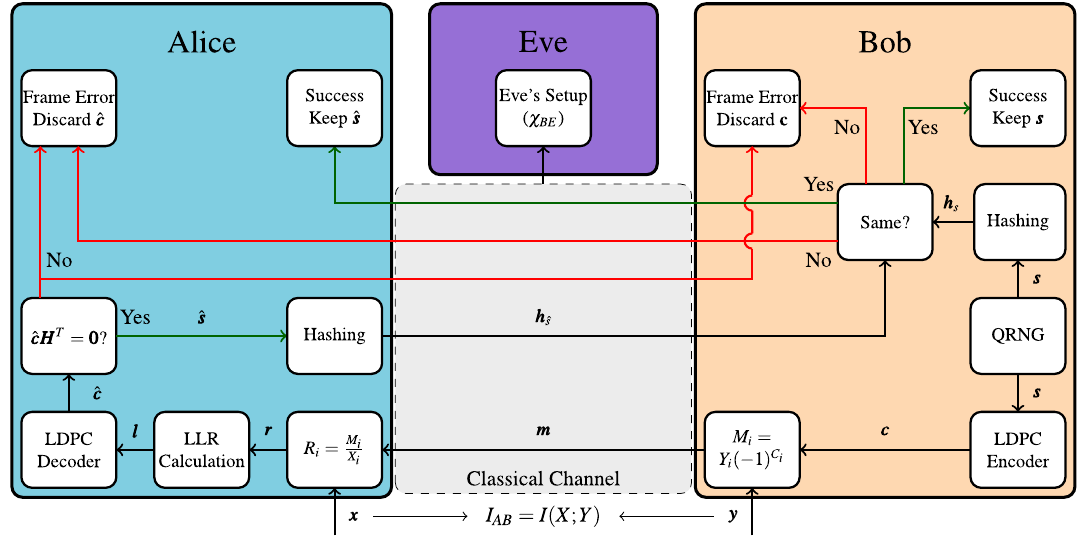
Figure 7. An overview of the one-dimensional reconciliation protocol for CV-QKD considered in this paper. The goal of reconciliation is for Alice and Bob to have the same sequence after error correction (e.g., s = ˆ s ) using their sequences of measurement outcomes ( x and y ) respectively. Eve has full access to the classical